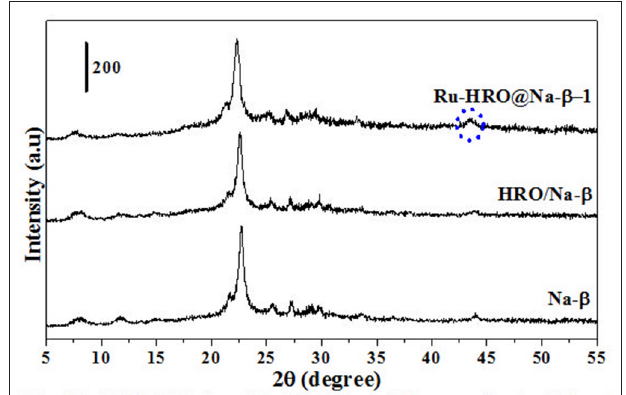
FIGURE 2 | PXRD of Na- β , HRO/Na- β , and Ru-HRO/Na- β -1 (Recovered material from Supplementary Table 2 , entry 1).